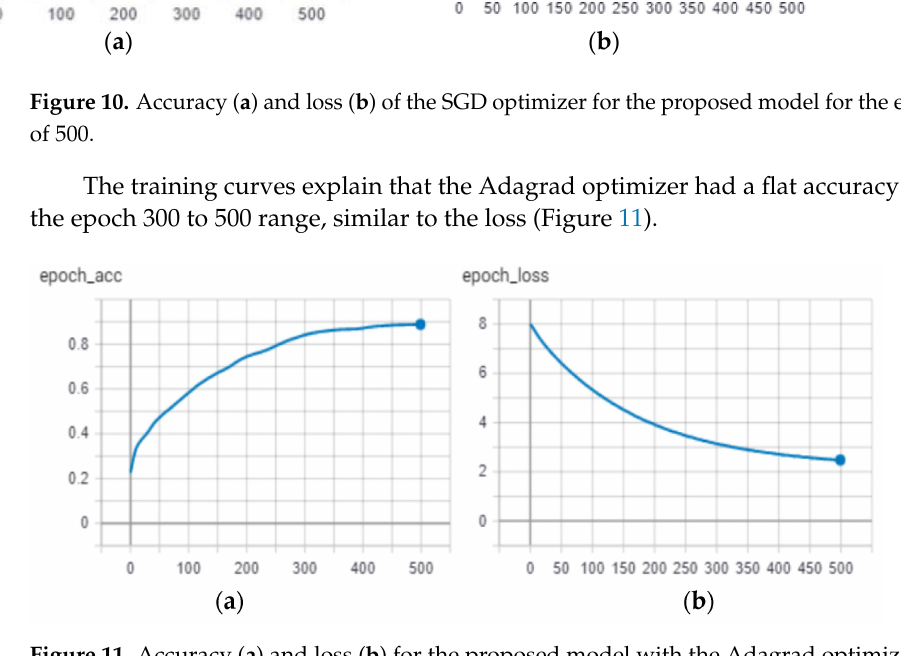
Figure 11. Accuracy ( a ) and loss ( b ) for the proposed model with the Adagrad optimizer for a 500 epoch count.